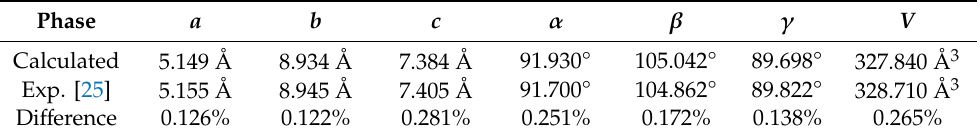
Table 1. Calculated vs. experimental lattice parameters of kaolinite (Al 4 Si 4 O 18 H 8 ) using basis sets described in the present study.